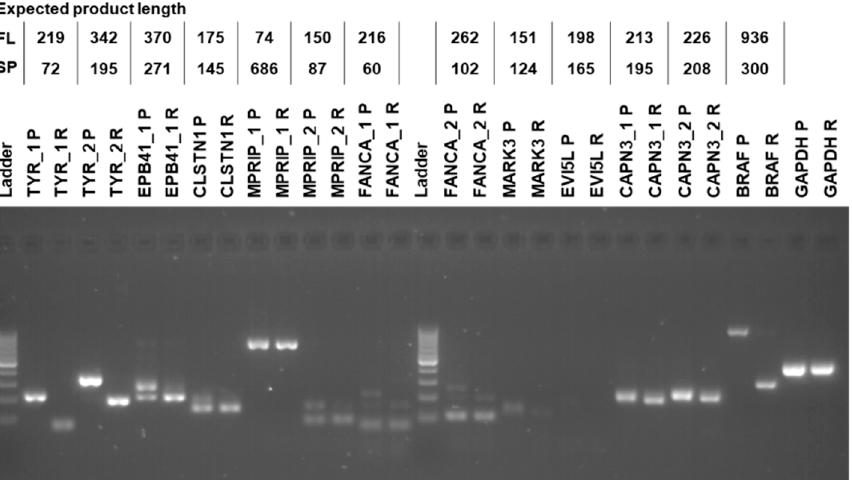
Figure 5. RT-PCR validation. Labels on the top of the gel image provide gene name, primer number in cases when more than one pair of primers were used, parental (P) or resistant (R) sample. Table on top provides the expected RT-PCR product sizes for the full-length (FL) and alternatively spliced (SP) product. Molecular weight DNA ladder marks product sizes from bottom to top: 100, 200, 300, . . . to 1000 bp.